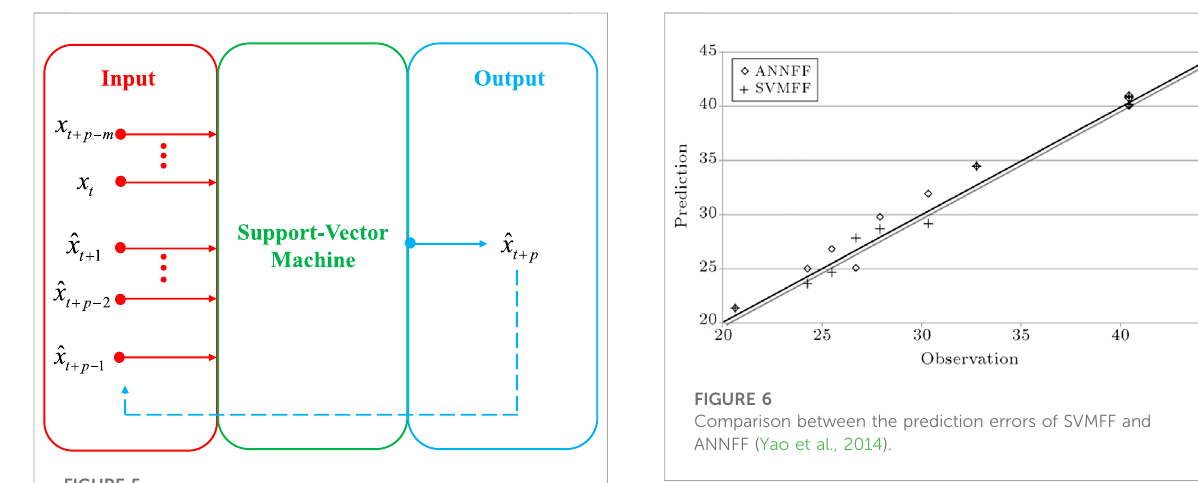
FIGURE 5 Thepredictionprocess ofMSbased onSVM(Yaoetal.,2010).